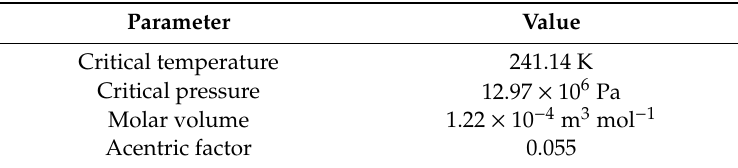
Table 2. Parameters of the Peng-Robinson state